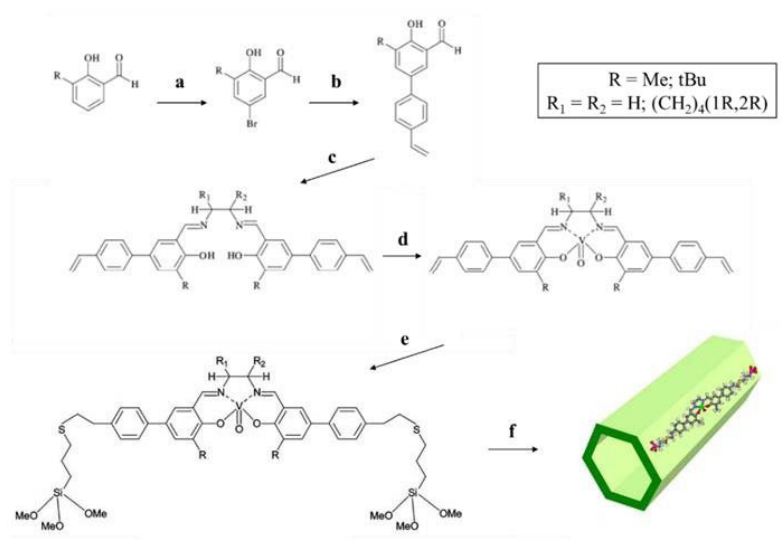
Figure 22. Schematic representation of the synthesis of PMOs containing vanadyl Schiff base com- plexes [115]. Reprinted with permission from [115]. Copyright 2004, Elsevier.